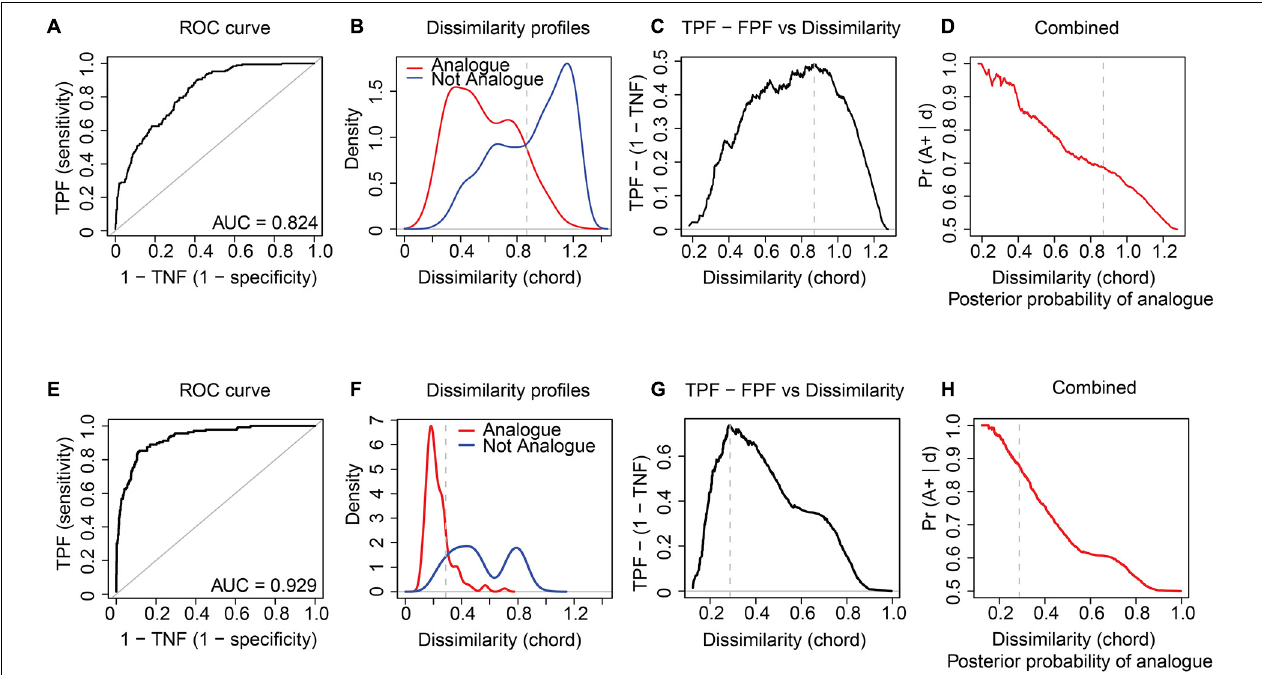
FIGURE 3 | Receiver operating characteristic (ROC) curve analysis with chord distance applied to the log(x + 1) transformed modern sedDNA and modern pollen data for Omoloy lake II. The results indicate that vegetation types can be well discriminated based on modern sedDNA (A–D) and pollen assemblages (E–H) . The ROC curve and the area under curve (AUC) value assess the optimal critical dissimilarity value ( d crit ) (A,E) . Dissimilarity curves show the kernel density estimates of the distribution of pair-wise dissimilarities for analogues and non-analogues samples (B,F) . The sensitivity (true positive fraction: TPF) and the specificity (true negative fraction: TNF) against dissimilarities suggest the good performance of ROC curve analysis (C,G) . The posterior probability that any two samples are analogues is calculated based on TPF and FPF (D,H) . Vertical dashed lines mark d crit . All curves indicate the results of combined vegetation groups.